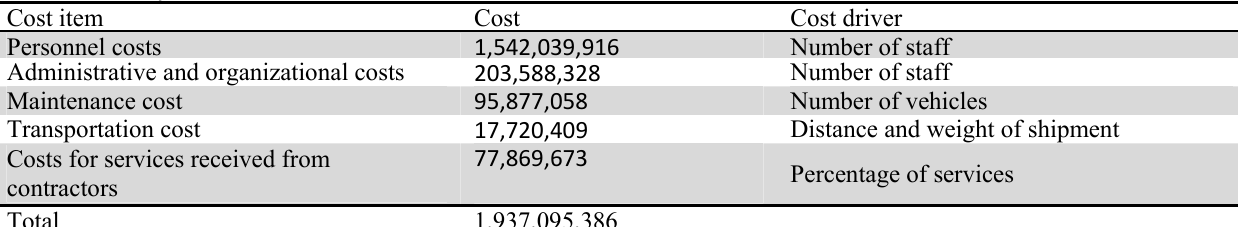
The summary of cost driver and cost items